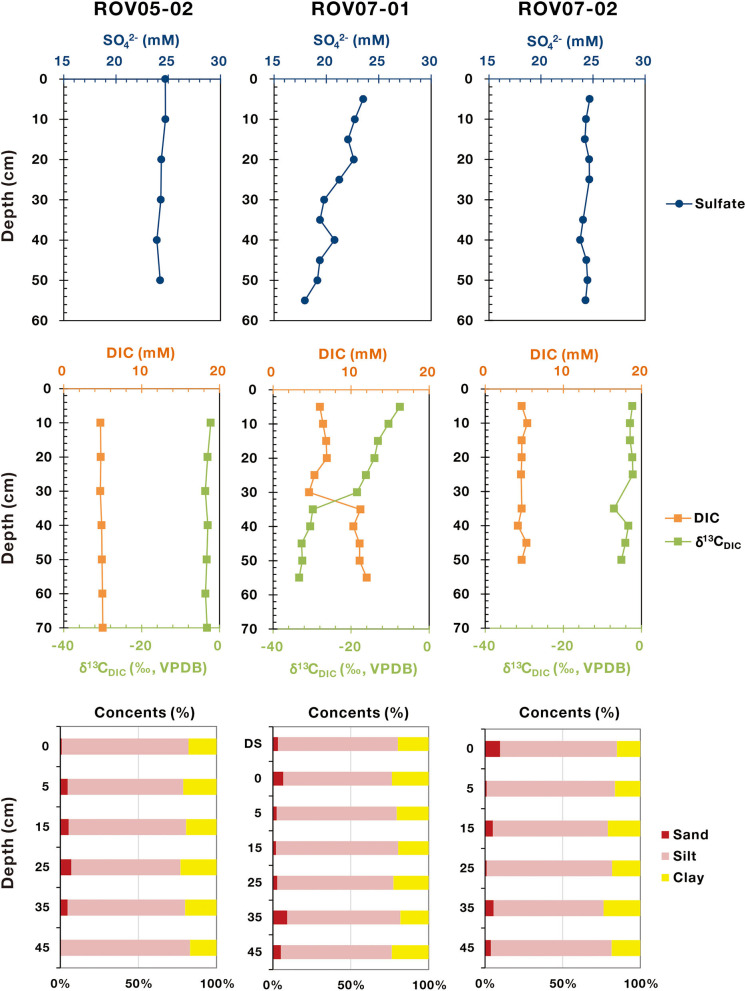
Geochemical profiles of sulfate, DIC, δ13CDIC, and particle sizes in the sediments of cold seeps. The sulfate, DIC, and δ13CDIC data are quoted from Feng et al. (2020).